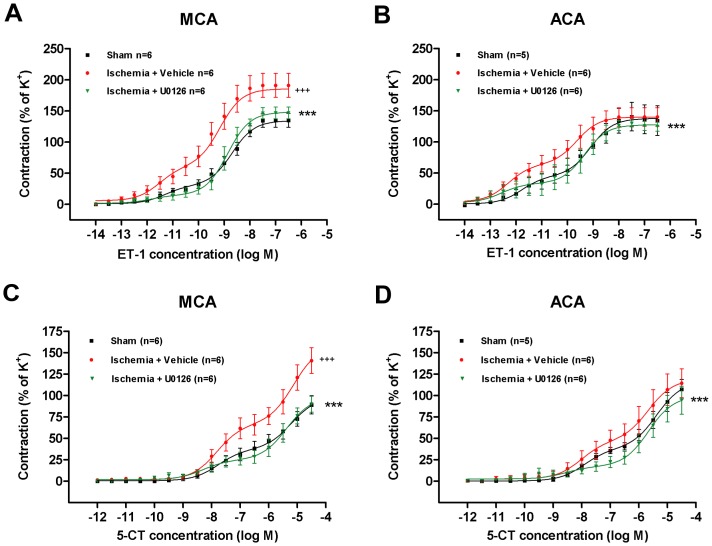
Effects of U0126 on enhanced vasoconstriction.Graphs showing concentration-contraction curves for MCAs (A and C) and ACAs (B and D) stimulated with cumulative doses of ET-1 (A and B) or 5-CT (C and D) obtained 3 days post-surgery. Data show sham-operated rats (sham), ischemia-induced rats treated with vehicle (ischemia + vehicle) and ischemia-induced rats treated with U0126 (ischemia + U0126) (30 mg/kg). Values are expressed as means ± SEM in percentage of contractions evoked by 63.5 mM of K+. Crosses indicate significant differences between sham and vehicle-treated ischemia-induced animals as determined by 2-way ANOVA. Stars indicate significant differences between U0126- and vehicle-treated ischemia induced rats as determined by 2-way ANOVA. n = 5–6 rats in each group. ***p<0.001